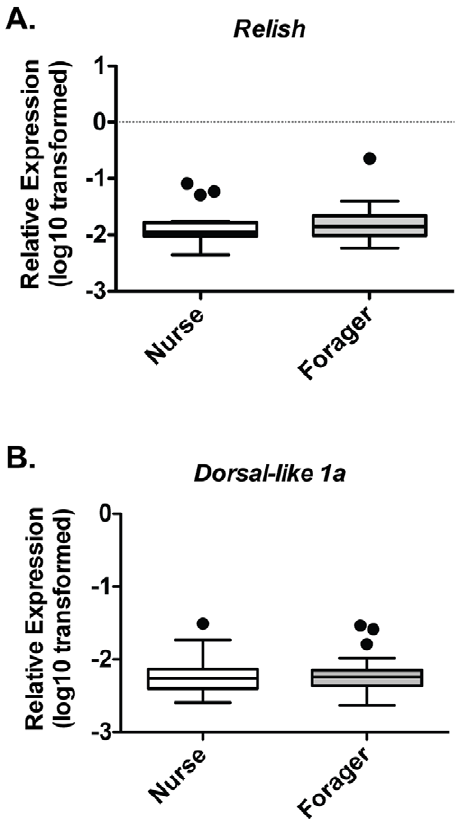
Figure 3. NF k B-family transcriptional activators of the Toll and Imd pathways are similar in nurses and foragers. Individual levels of Relish (A) and Dorsal-like 1a (B) relative to b -actin in midgut tissue from Nurses (n=23) and Foragers (n=22) from trials 1, 3, and 5. Boxes show 1st and 3rd interquartile range with line denoting medians. Whiskers encompass 95% of the individuals. Outliers are denoted with filled circles.